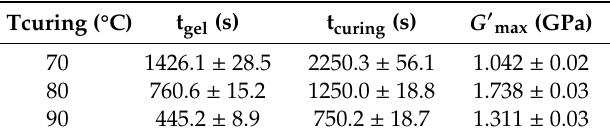
Table 4. Gel time (t gel ), curing time (t curing ), and maximum storage modulus ( G’ max ) of the partially bio- based epoxy resins after the different curing temperatures.